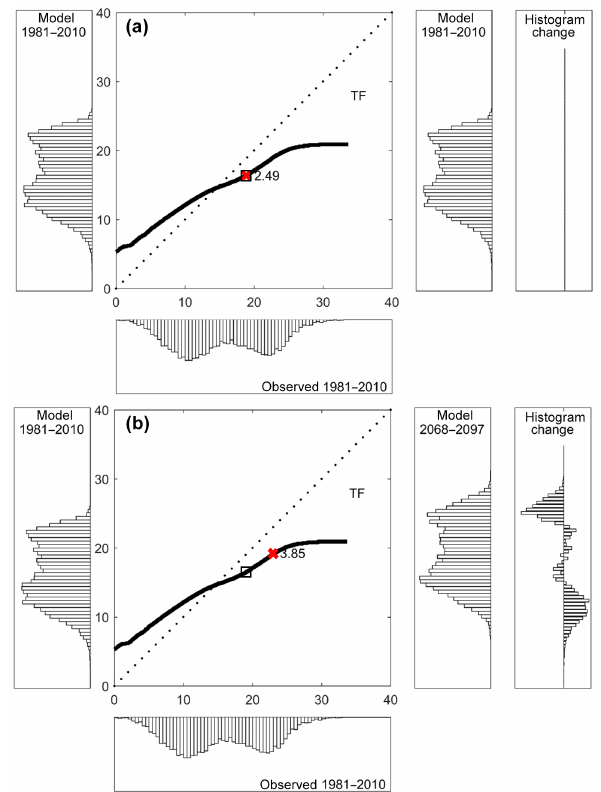
Figure 1. The transfer function (TF – heavy black line) between observed (bottom histograms) and modeled (histograms on the left) for the reference period (1981–2010) is used to adjust bias of a 30-year moving window from 1981–2010 to 2068–2097. The rightmost plot shows the residual histogram after bias correction. The change in the average correction (red mark) on the TF in comparison to the reference period mean correction (square) is shown. The animated version provided in the Supplement shows the temporal evolution of the bias as the 30-year time window moves on the projection data. Data were obtained from ICHEC-EC- EARTH r12i1p1 SMHI-RCA4_v1 RCM of Euro-CORDEX experi- ment (0.11 ◦ resolution) simulation under the representative concen- tration pathway of RCP85, for the location Chania International Air- port (long = 24.08, lat = 35.54). Observational data were obtained from the E-OBS v14 dataset (Haylock et al., 2008) of 0.25 ◦ spatial